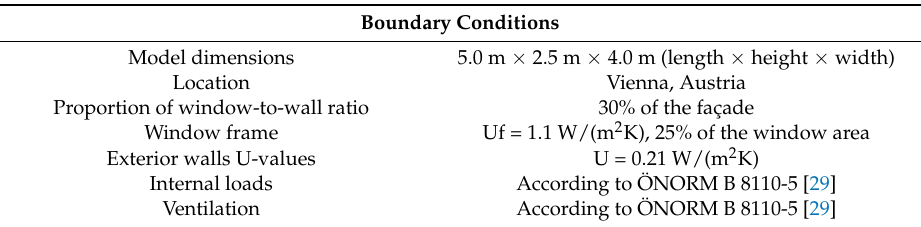
Table 1. Boundary conditions for the thermal dynamic